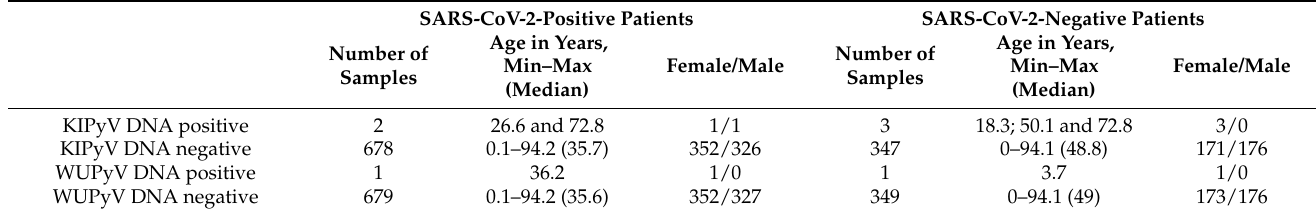
Table 3. Detailed data of patients studied for KIPyV and WUPyV DNA